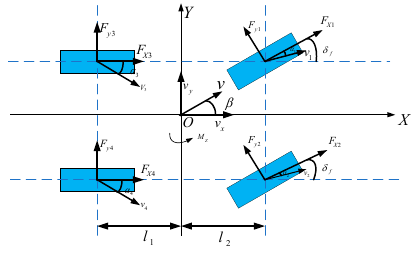
Figure 2. Seven DOF vehicle model. Longitudinal movement: